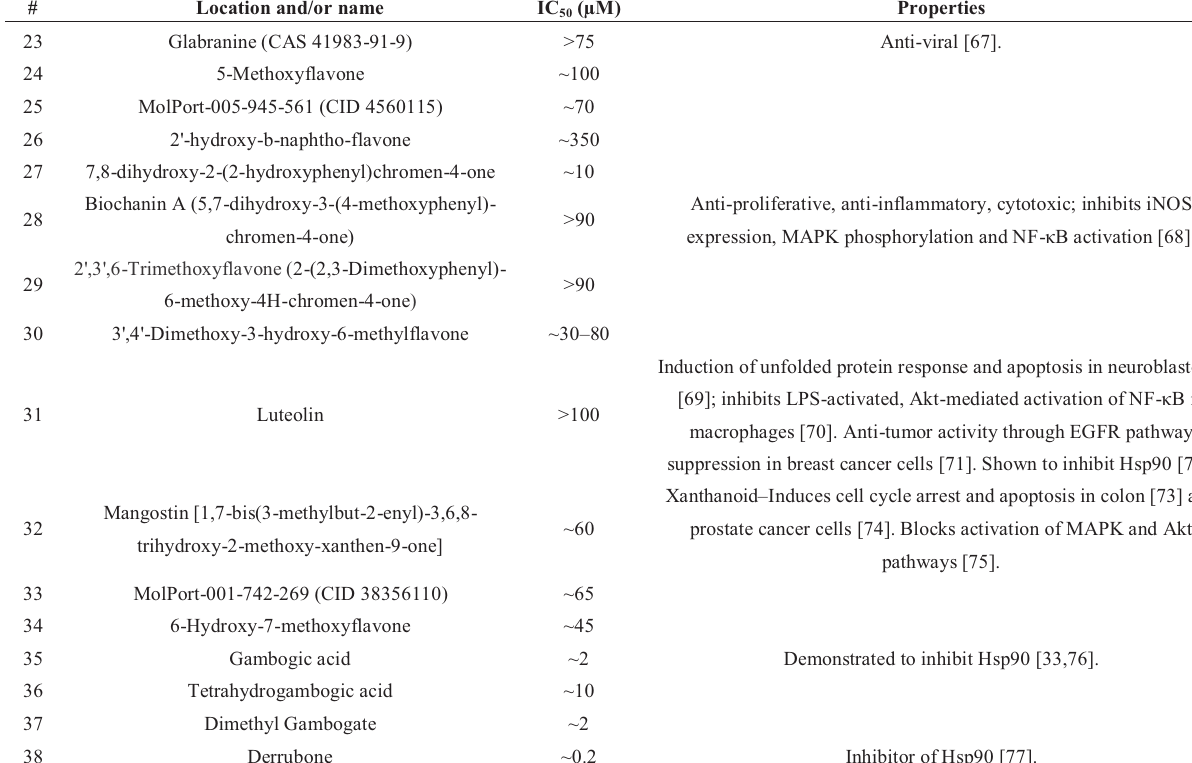
Table 3. Flavonoids.